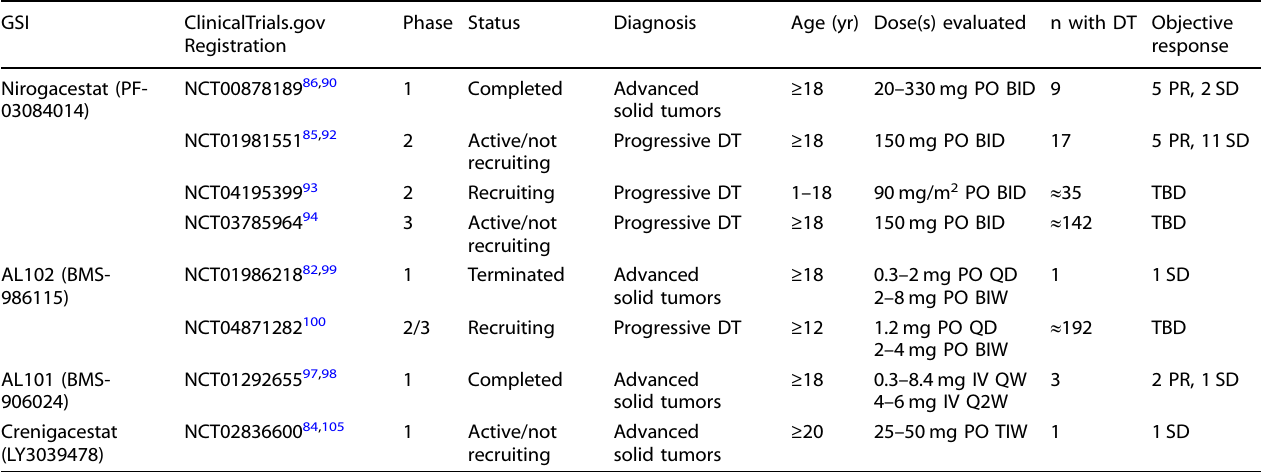
Table 1. Clinical trials of γ -secretase inhibitors in the treatment of desmoid